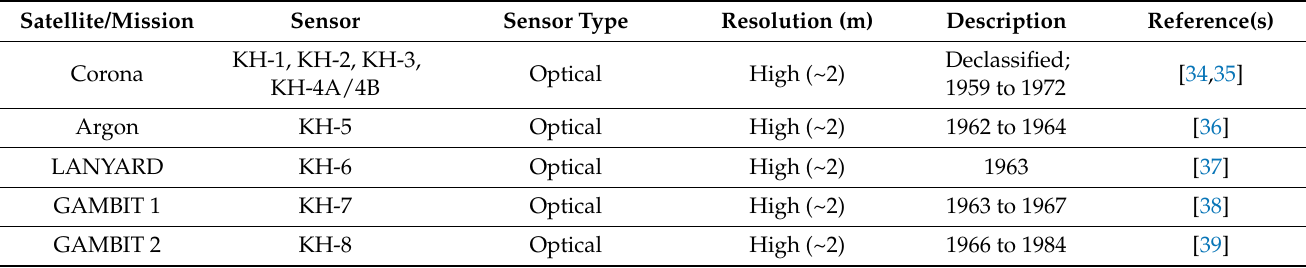
Table 2. Some open access earth observation mission and